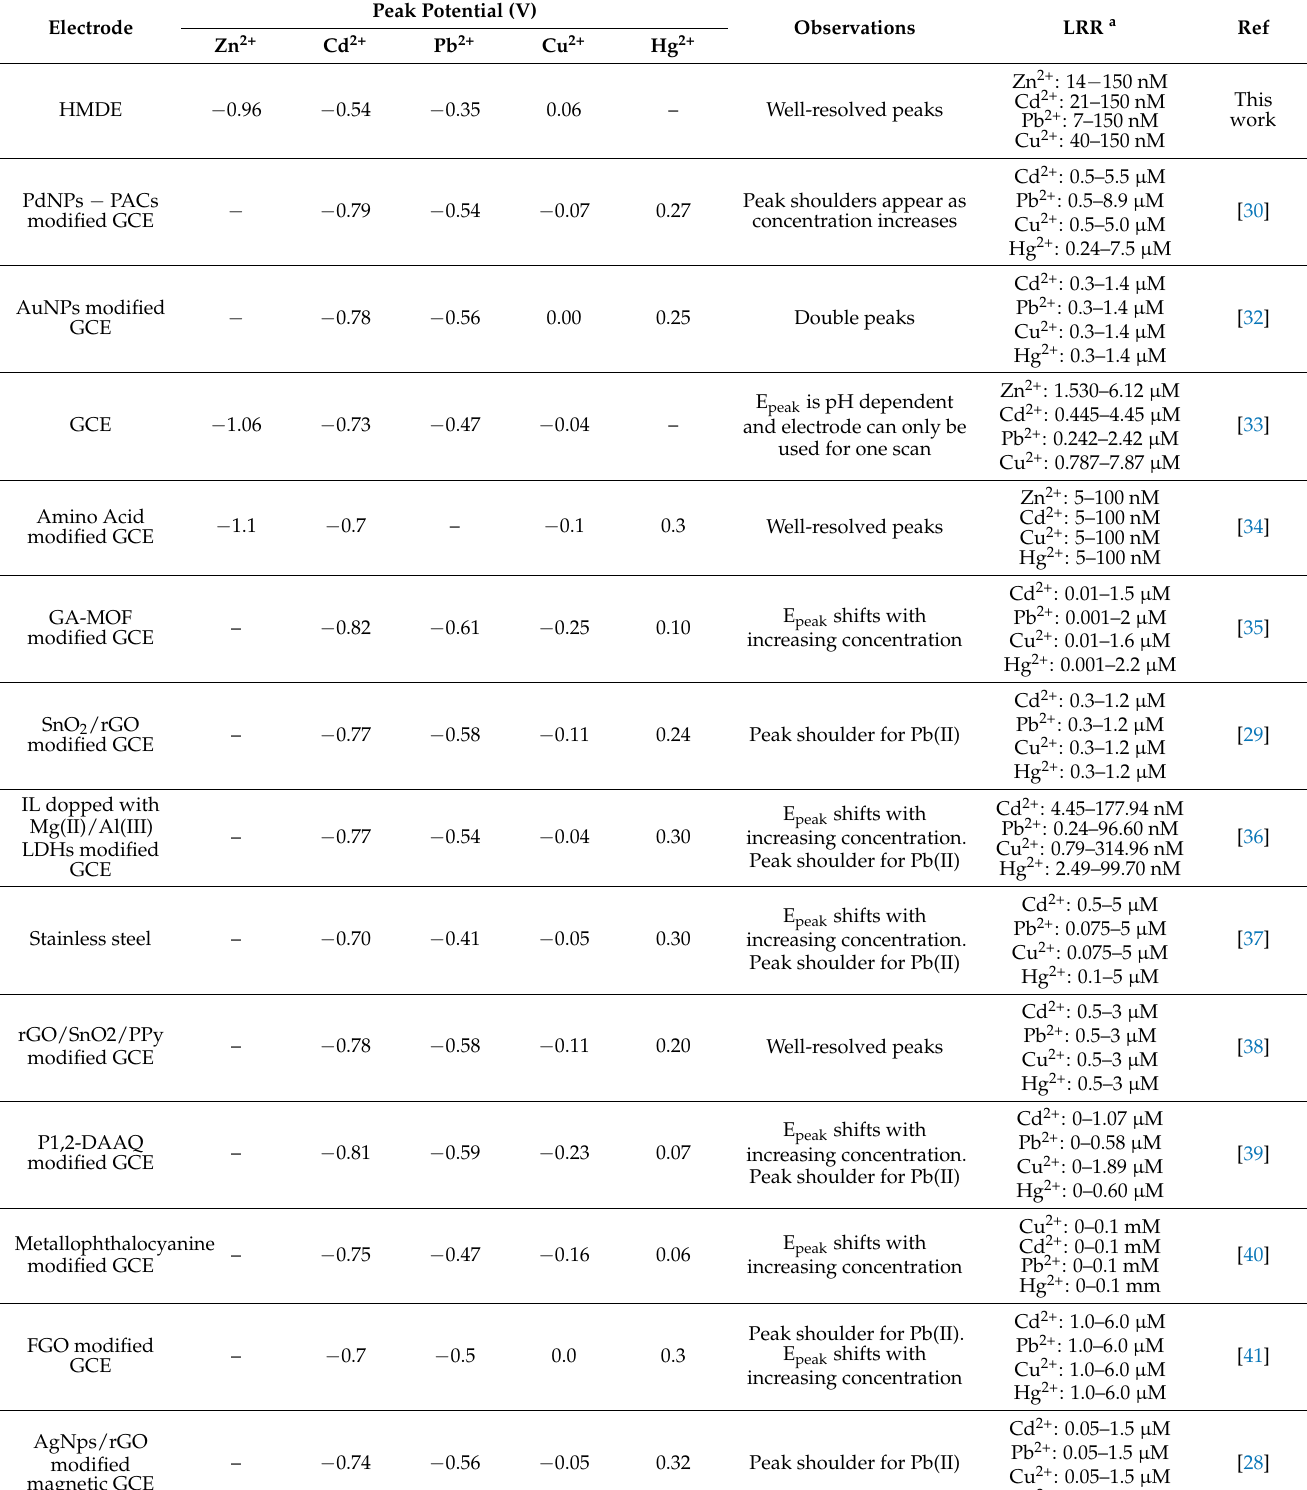
Table 1. Some parameters reported in the literature for the electrodes reported as an alternative for the HMDE. The results obtained herein with the HMDE are also collected for comparison